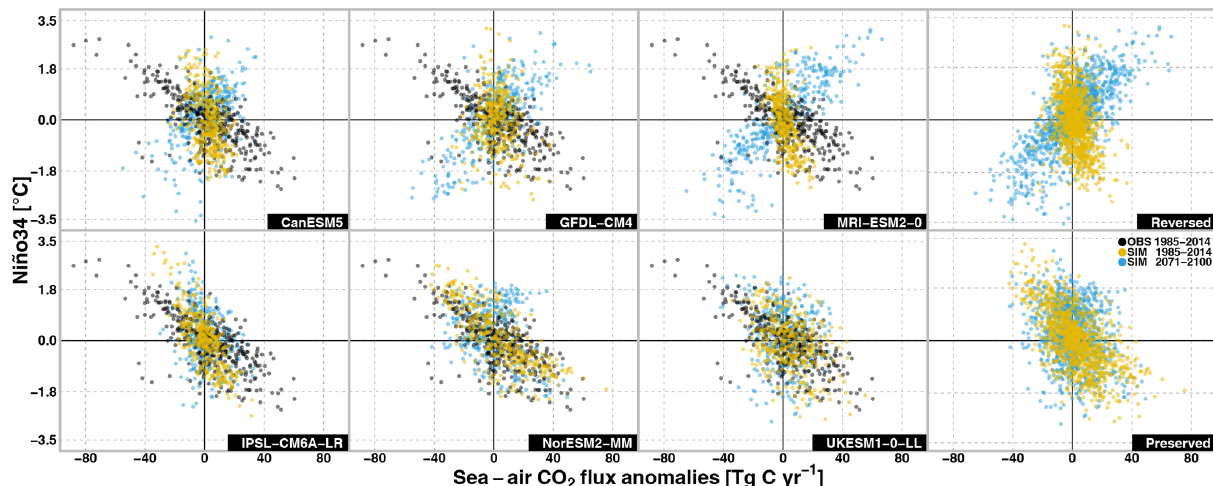
Figure 5. Scatter plots for the six selected models of the monthly Niño34 index (in ◦ C) against the monthly CO 2 flux anomalies (in TgCyr − 1 ) averaged over the EP domain in the 1985–2014 contemporary period (in yellow) and the 2071–2100 period (in blue). The observed scatter plot is given in black. The top panels show CanESM5, GFDL-CM4, MRI-ESM2-0, and all reversed ESMs. The bottom panels are for IPSL-CM6A-LR, NorESM2-MM, UKESM1-0-LL, and all preserved